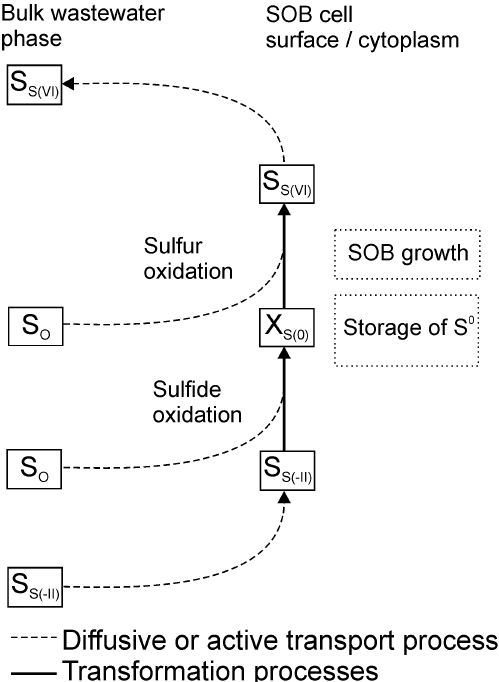
Figure 4. Model concept for biological sulfide oxidation with transport, transformation, and storage of sulfur compounds and associated growth of SOB.